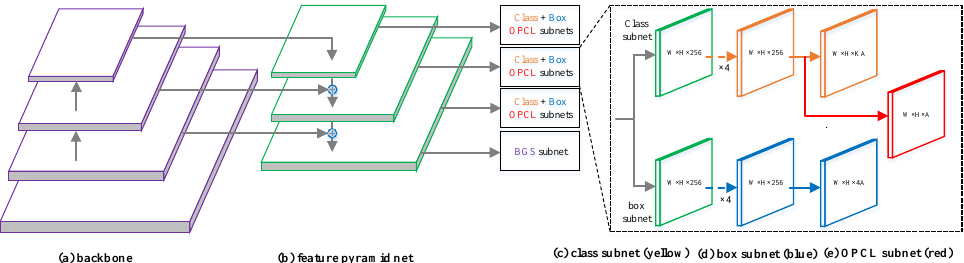
Figure 5. Illustration of our detector, which contains the backbone, feature pyramid net (FPN), and prediction head. The prediction head includes classification, regression, and Offsets Prediction between the Classification and localization (OPCL) head. The Boundary Guided Supervision module (BGS) is only attached at P 3 of